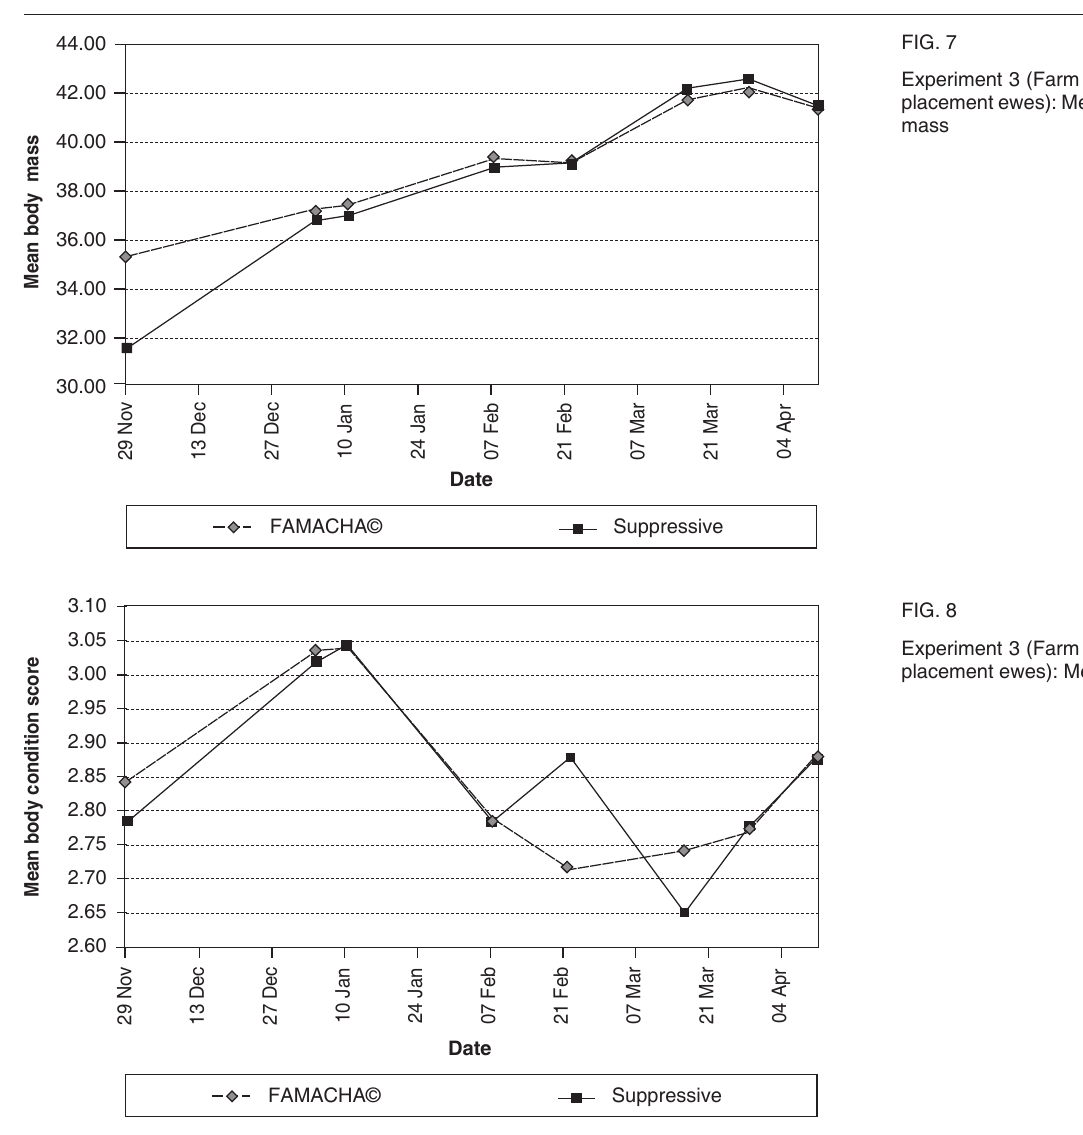
Experiment 3 (Farm 2, young re- placement ewes): Mean